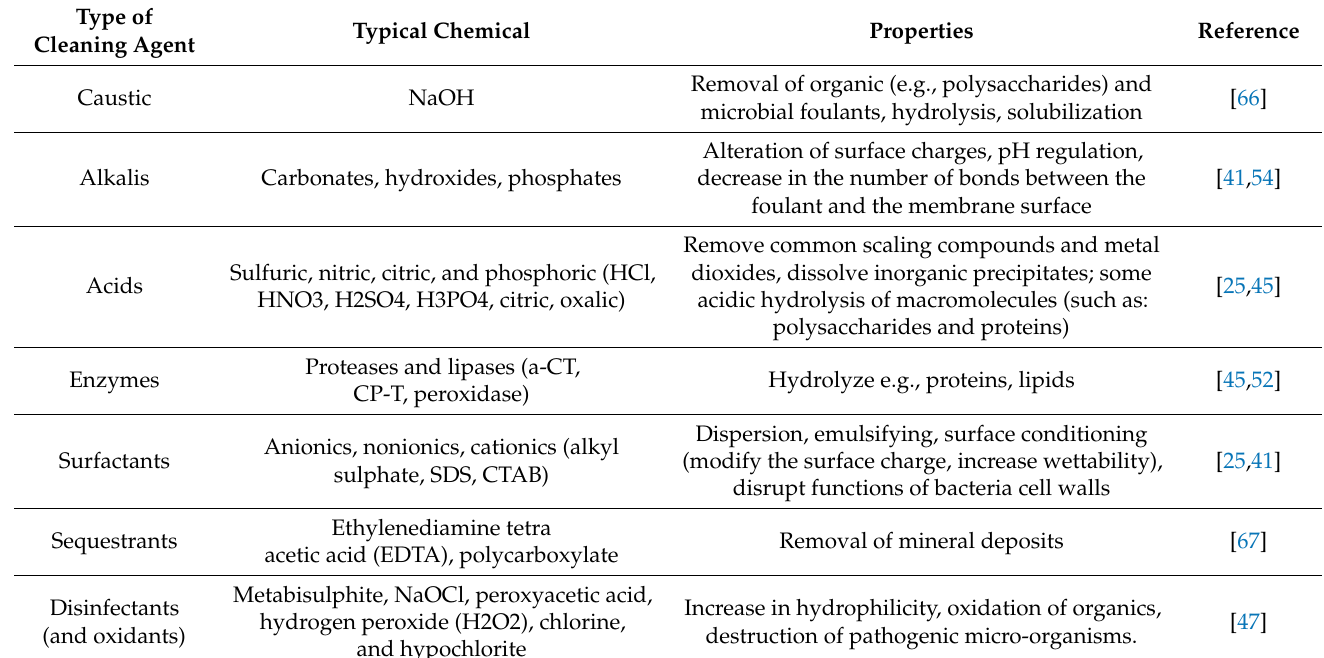
Table 6. Common cleaning